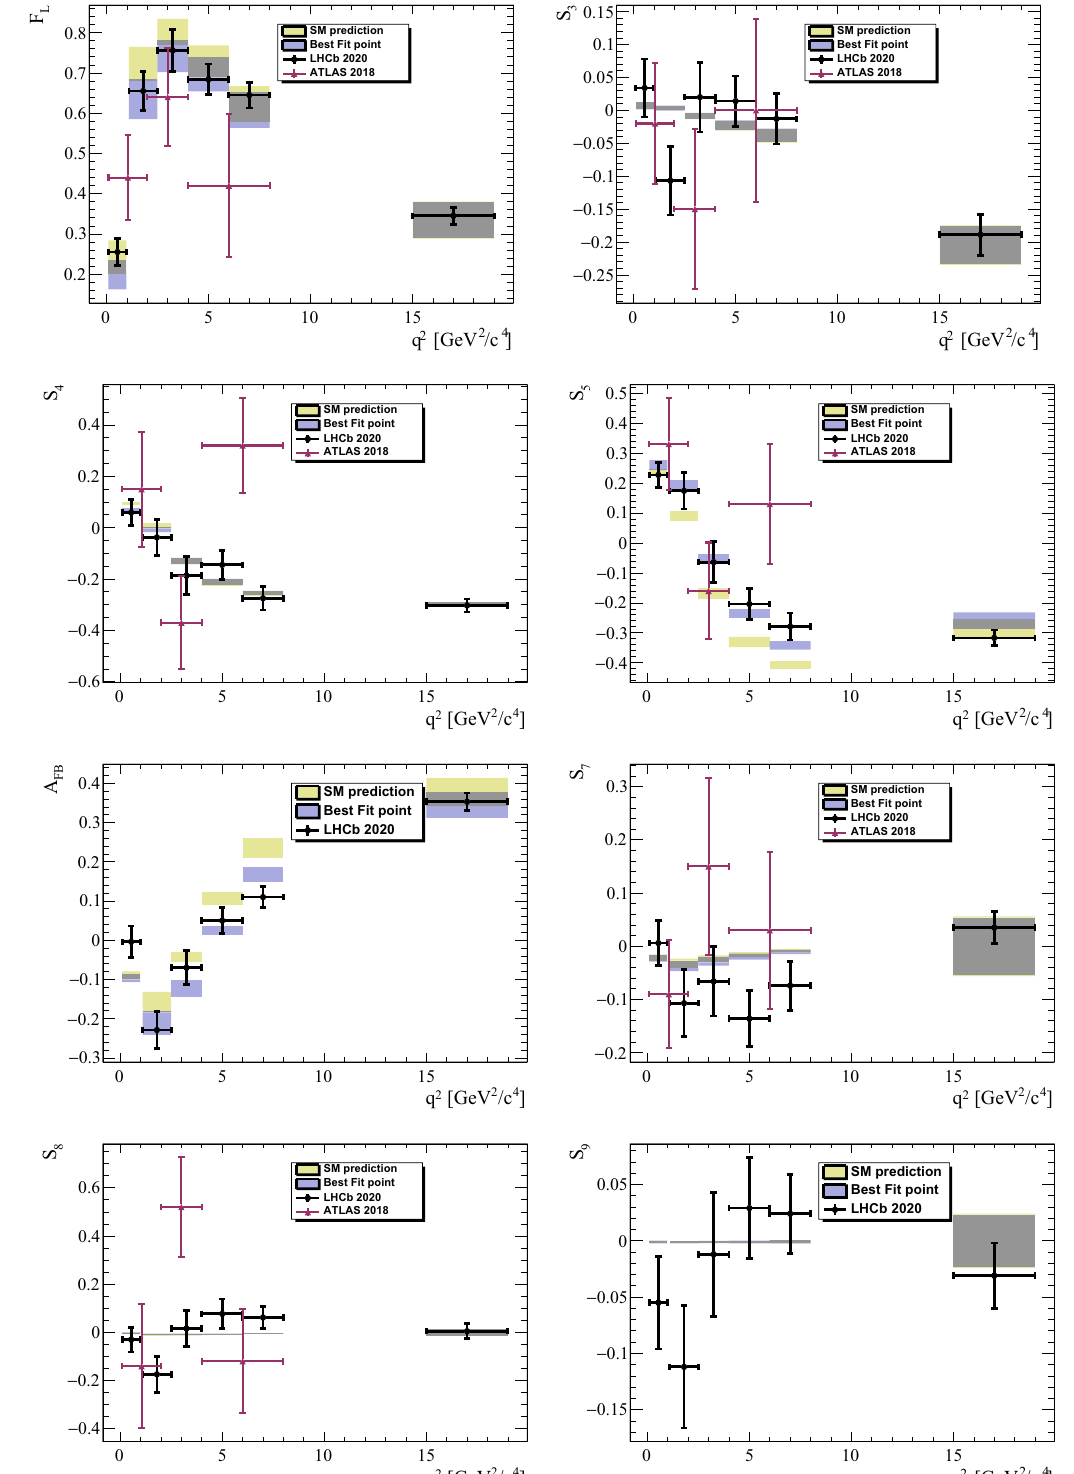
Fig. 2 Angular observables for the decay B d → K ∗ 0 μ + μ − included in our fit. Yellow shading corresponds to Standard Model predictions and uncertainties, and blue shading shows the prediction of our best-fit model.DatapointswitherrorbarsshowmeasurementsfromLHCb[48]